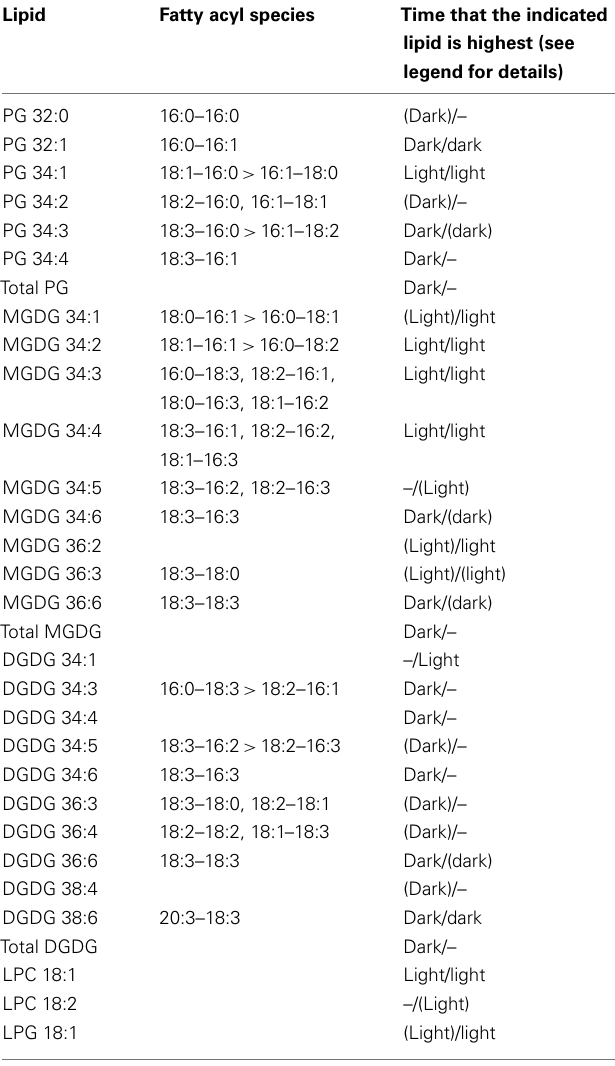
initial experiment in which an increase in total PA in the dark was observed ( Figure 1 ). PA and PS were the only two classes in which allsignificantlychangedlipidspecieswithintheclasseswerehigher in the dark. This was true whether the data were normalized to extracted dry mass or considered as percentage of total lipid